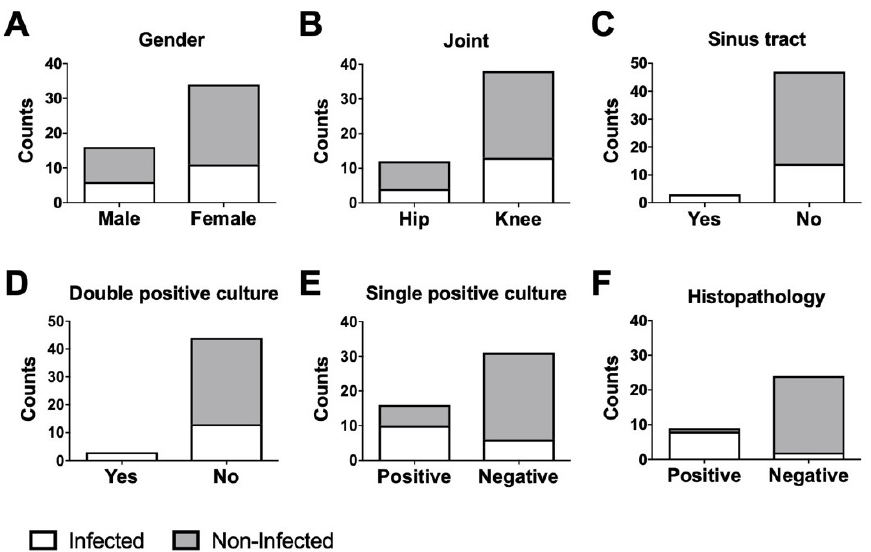
Figure 1. Demographic features of the non-infected and infected groups. Distribution of ( A ) gender, ( B ) joint type (hip or knee), ( C ) patients with or without joint-communicating sinus tract, ( D ) double-positive microbiological result, ( E ) single-positive microbiological result , and ( F ) positive histopathology report in the non-infected and infected groups.